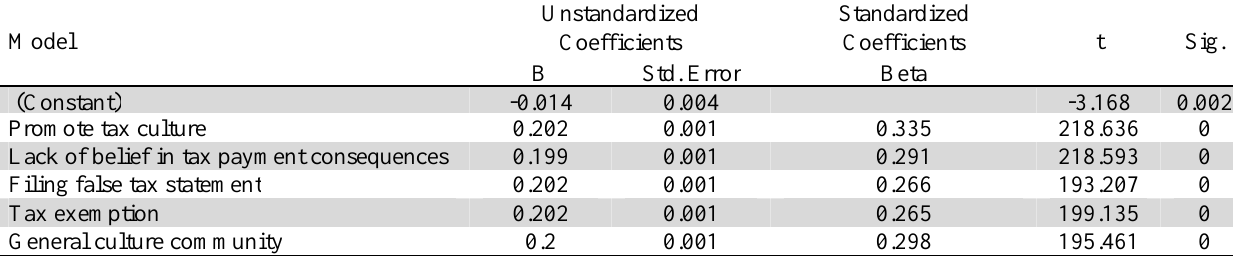
The summary of regression technique